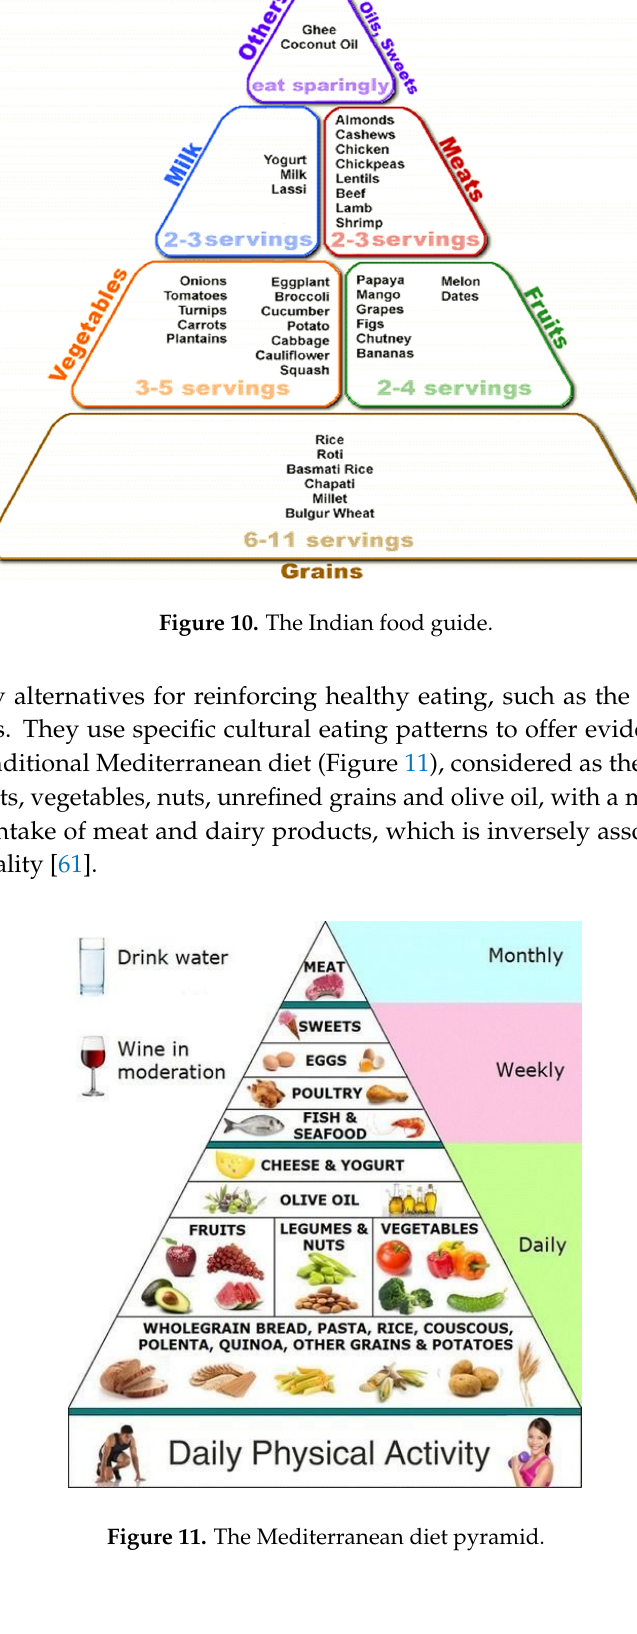
Figure 12. The Portuguese food wheel guide. 11. A Comparison of Inclusion of Fermented Products in Different Guides Evaluating dietary guidelines from various countries can help identify their strengths and limitations, yet such assessments are lacking due to the complexity involved. Trying to compare qualitatively current population ‐ level dietary recommendations and pictorial food guides issued by government or nutrition agencies across nutrition transition stages (early, ongoing, and transitioned) is almost an impossible task. The recommendations for consumption of foods or dietary practices within main categories of food groups, nutrients, or beverages, including lifestyle, nutritional, cooking, or eating habits is an intricate process. Some 55 major nutrients are reasonably well characterized and their required levels of intake calculated; however, the subject becomes quite complex if taking into account the amount 1-3 servings 4–11 servings